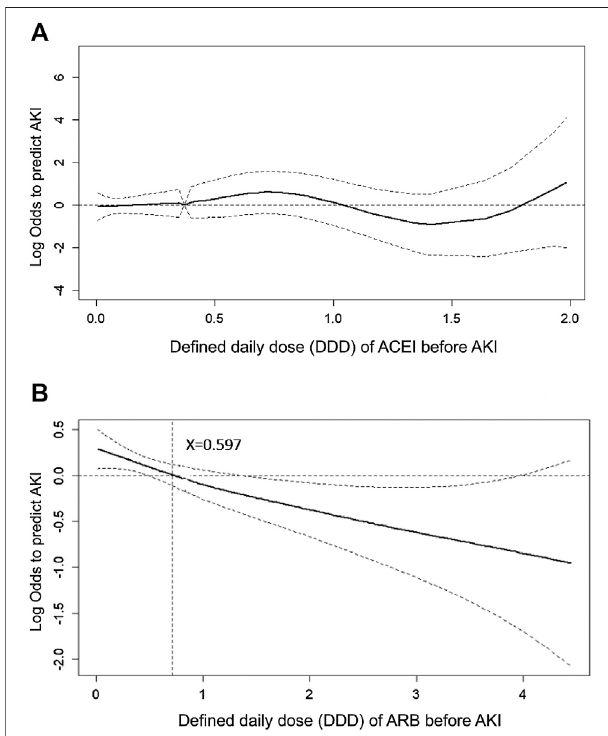
FIGURE 4 | Generalized additive model plot of the probability of postoperative acute kidney injury for ACEI or ARB usage quantity. The probability of postoperative AKI, expressed as the logarithm of the odds, was constructed with the de fi ned daily dose of ACEI (A) or ARB (B) usage and was centered to have an average of zero over the range of the data as constructed with the GAM. Both models are adjusted for age; gender; baselineeGFR;andtheuseofcyclooxygenaseinhibitors,alpha-blockers,and calcium channel